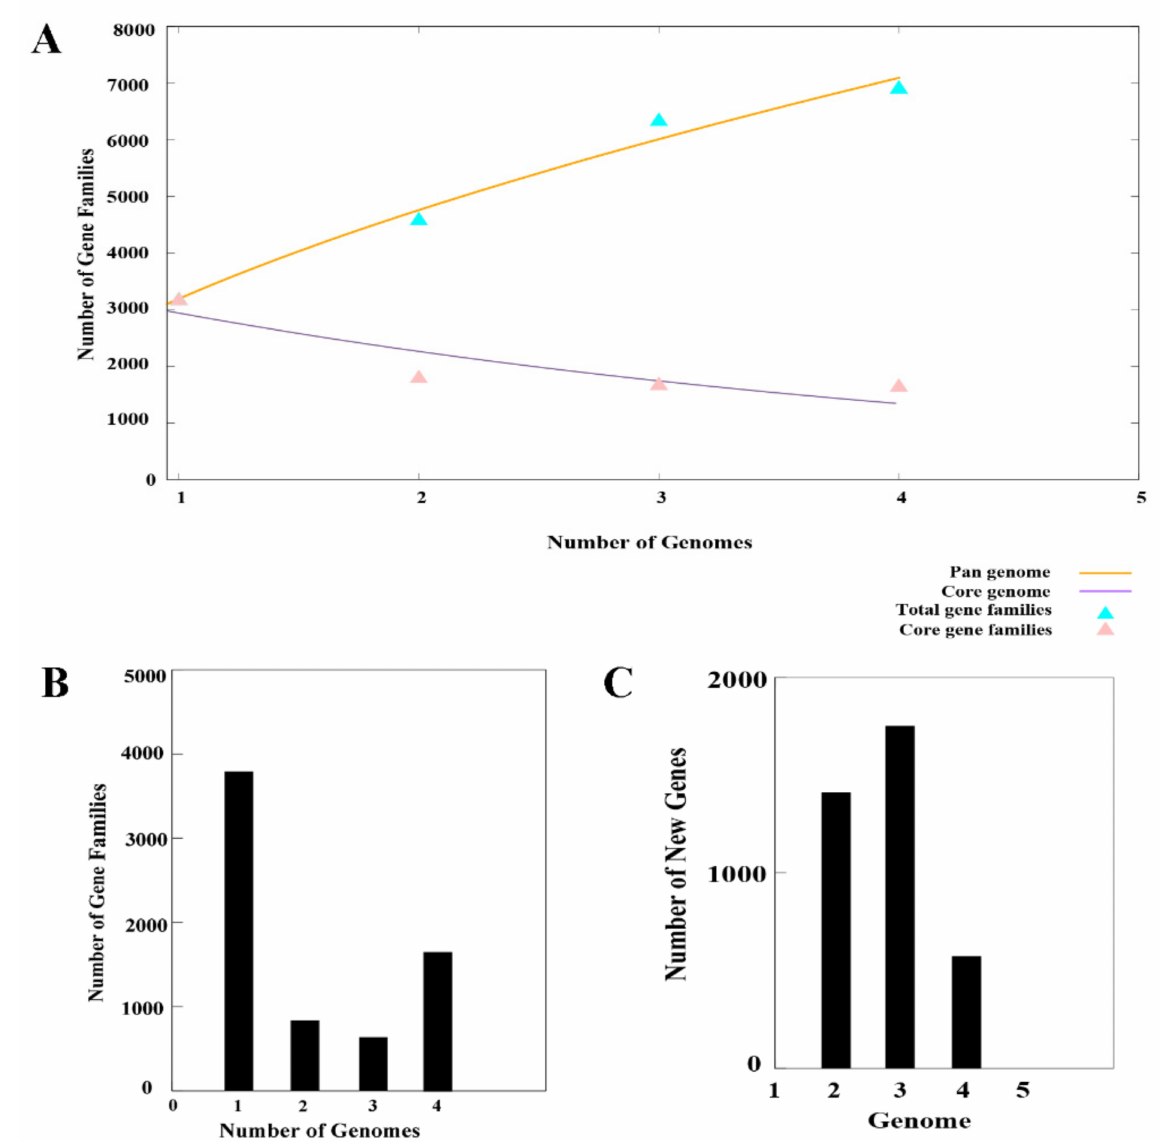
Figure 6. The pan genome of L. populi N-5-1 and three closely bacterial genomes. ( A ) Mathematical modeling of pan/core genome of reference strains. The graph shows the size of the pan-genome (orange graphic bars) and size of the core genome (purple bar graphs). ( B ) The bar graph shows genes with varying degrees of conservativeness. ( C ) The number of new genes of four bacterial genomes and the relationship among their